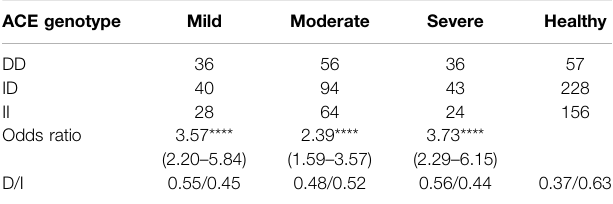
TABLE 2 | Distribution of the ACE genotype for different symptoms of COVID-19 patients according to risk status.